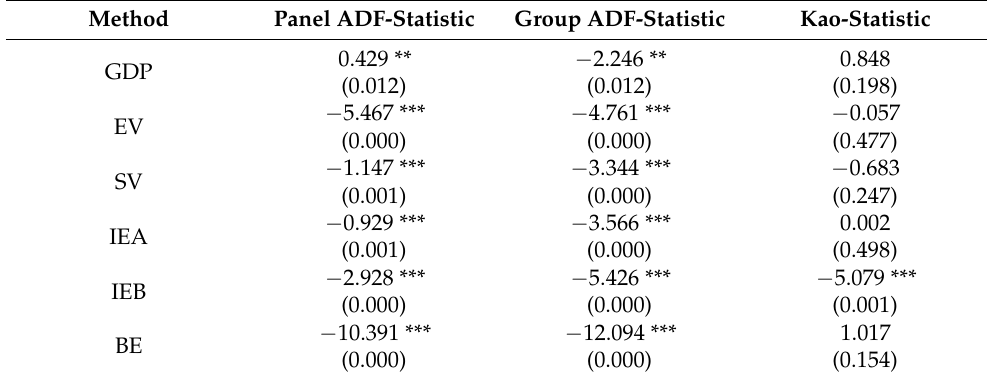
Table 4. Panel cointegration